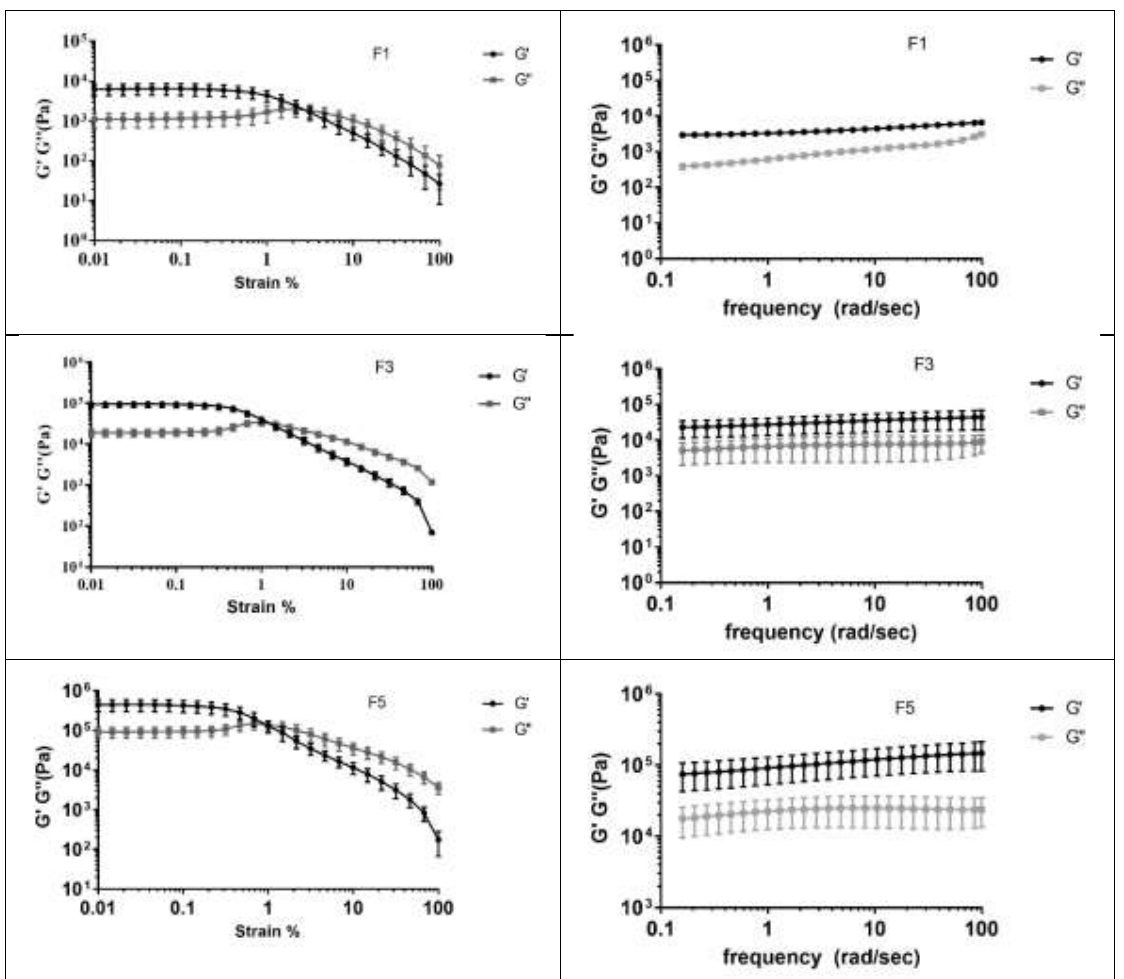
Figure 5. Rheology oscillatory Figures, the A, B and C represent the amplitude sweep, and the Figures D, E, and F represent the frequency sweep of the selected organogels of HOA in